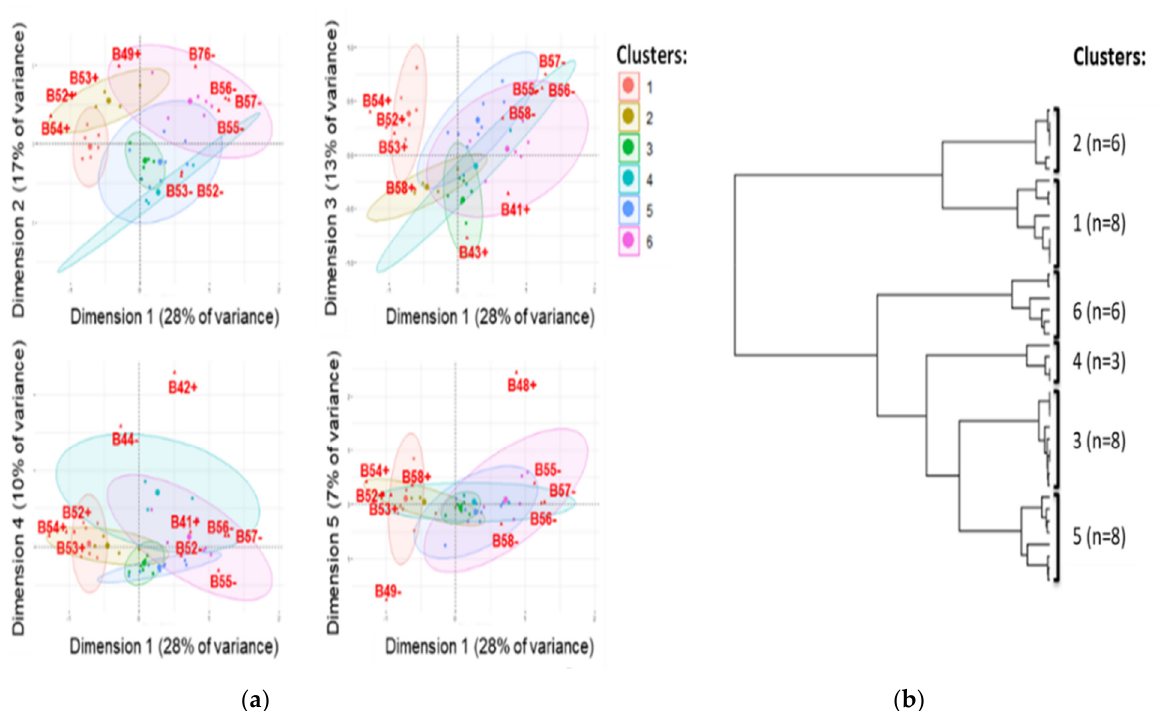
Figure 5. Multiple corresponding analysis ( a ) and hierarchical clustering ( b ) inferring synteny analysis of 39 circularised plasmids IncI1-ST3 encoding bla CTX-M-1 . The clusters are surrounded by 95% confidence ellipses, and the 10 most contribu- tory synteny blocks of sequences are indicated in red (B#: shuffling segment B associated with IS Ecp1 and bla CTX-M-1 ; #: position of the genetic feature, rv: reverse and fd: forward).